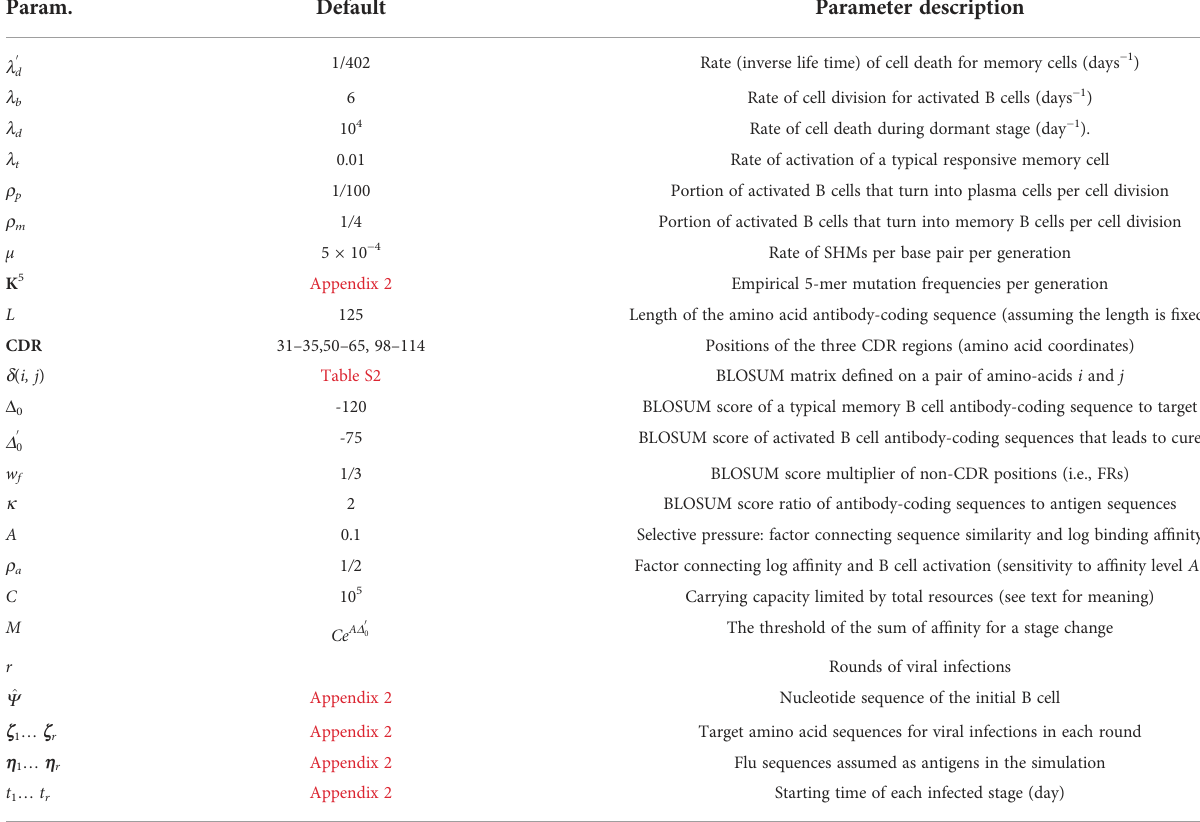
TABLE 1 Parameters of the AM model.